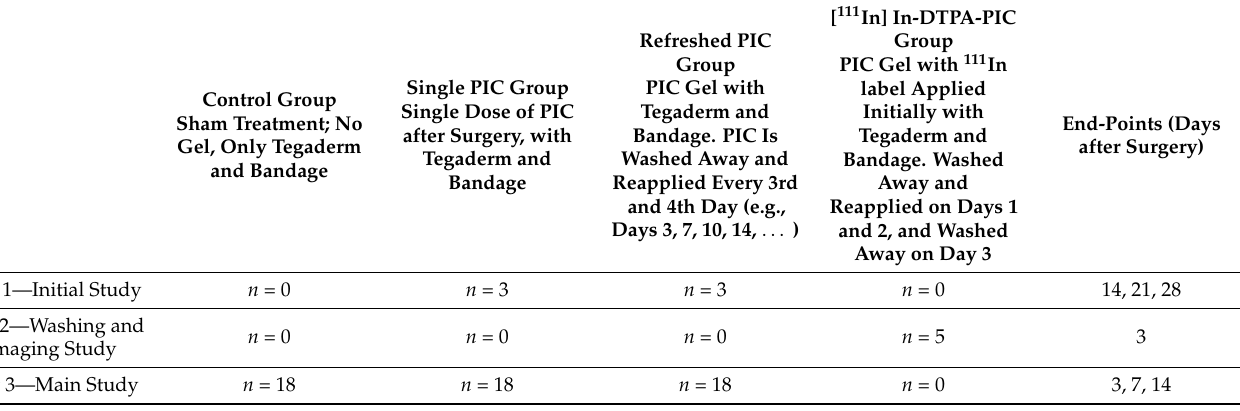
Table 1. Overview of the different groups used for the experiments (see also Section